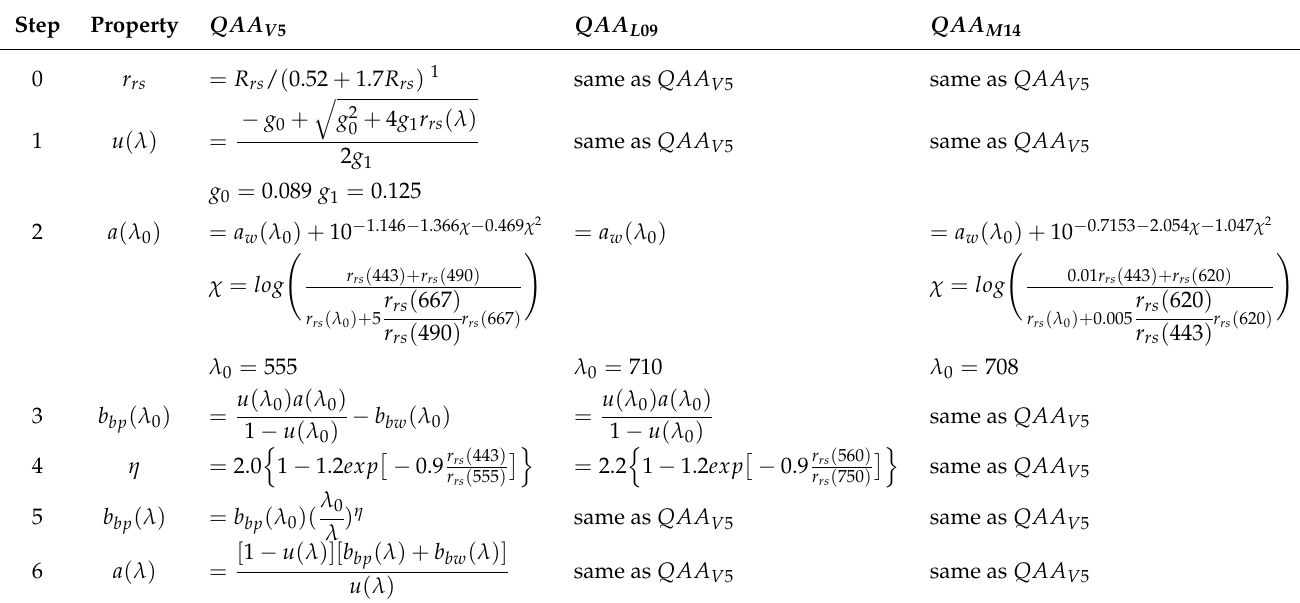
Table 2. Steps to derive the absorption and backscattering coefficients from QAA V 5 , QAA L 09 and QAA M 14